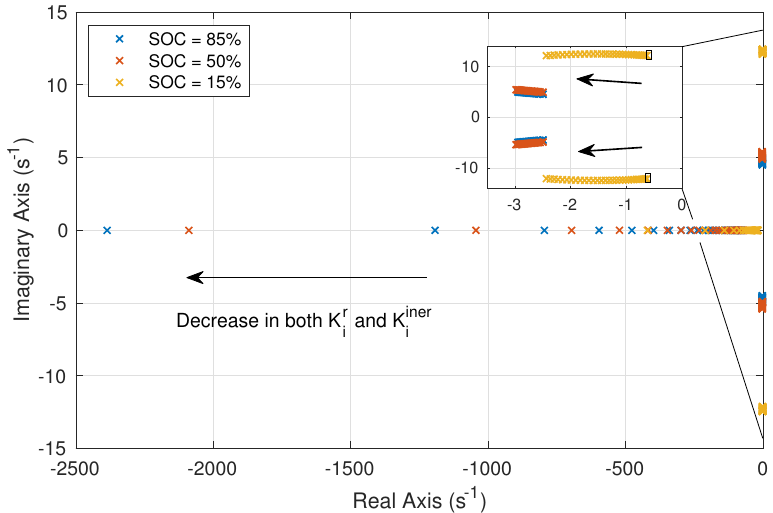
Figure 6. Eigenvalues trajectories of the third-order small-signal model of the proposed control system with decrease in both K r and K iner from 30,000 to 1000 and 300 to 10 i i